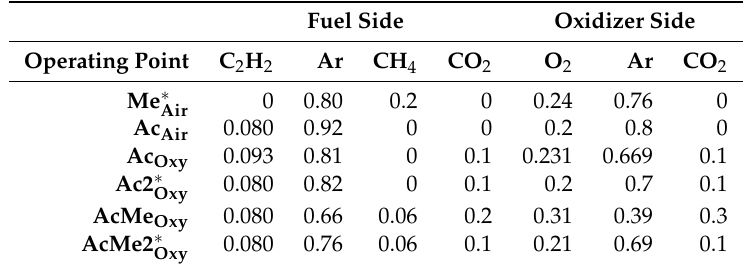
Table 1. Species mole fractions and flow rates for all operating points. The global strain rate (see [15]) for all operating points is 70 1 and the oxidizer and fuel stream are momentum balanced. Operating s points marked with ∗ have not been presented in [1]. The operating points are abbreviated as Me for Methan, Ac for Acetylene and AcMe for the addition of methane to the acetylene fuel. The subscripts indicating wether air or oxyfuel atmosphere with CO 2 was